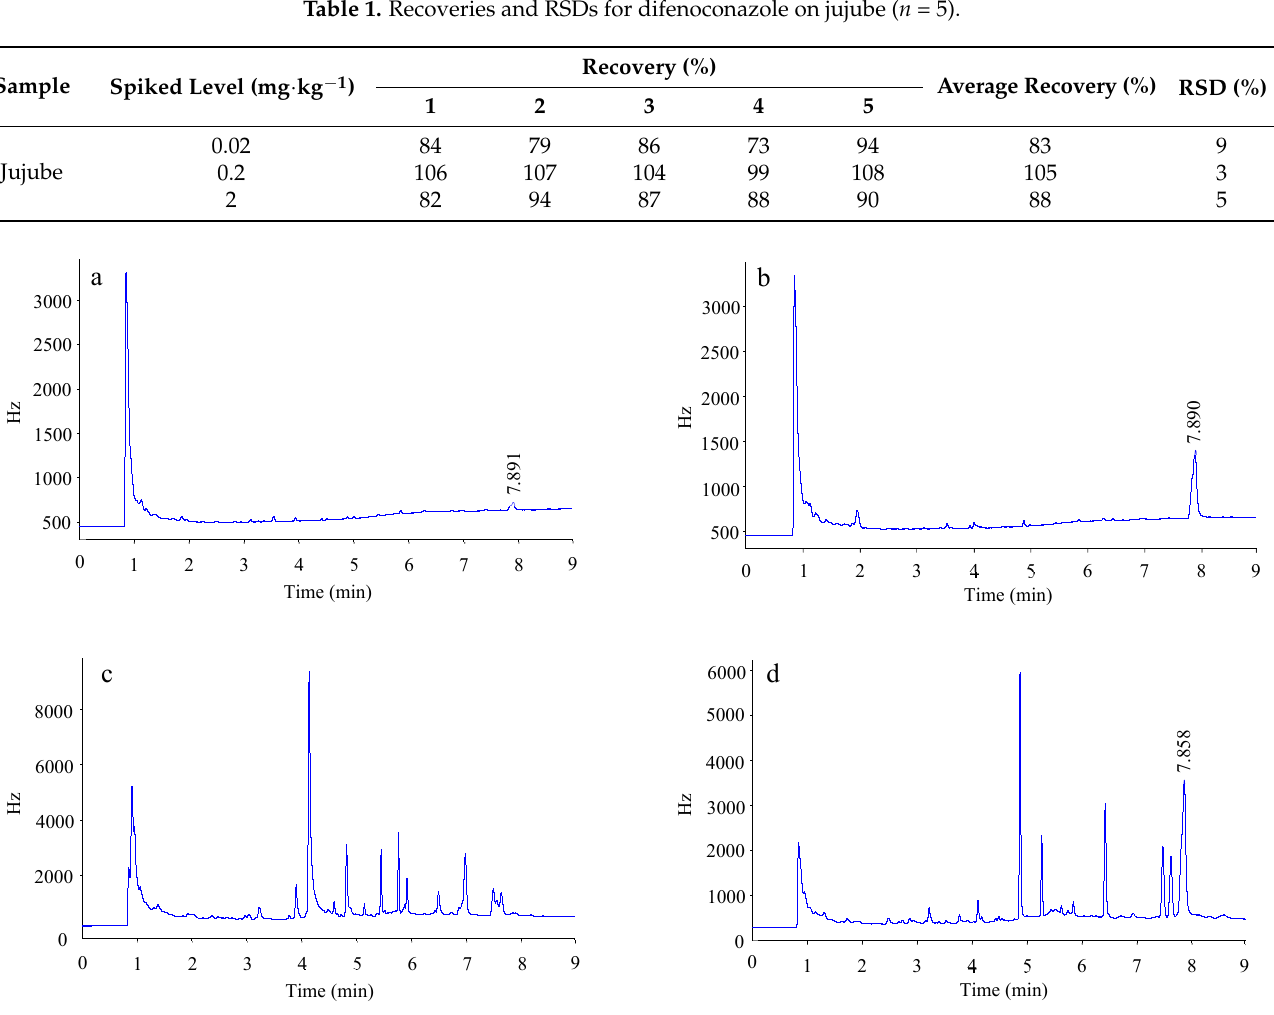
Table 1. Recoveries and RSDs for difenoconazole on jujube ( n = 5).